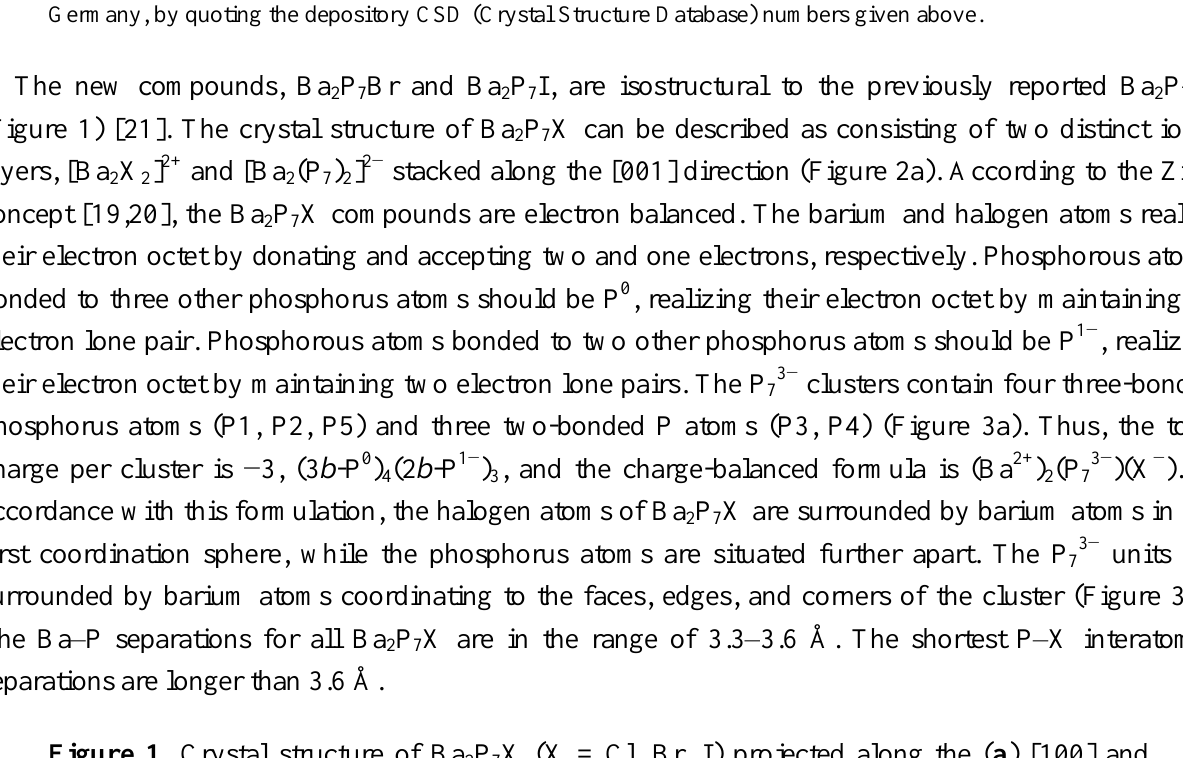
P X (X = Cl, Br, I) projected along the ( a ) [100] and 2 7